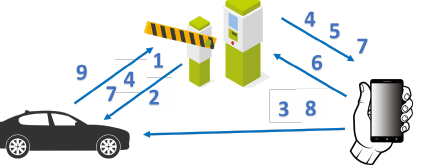
Figure 1. Basic communication in the automated cycle.